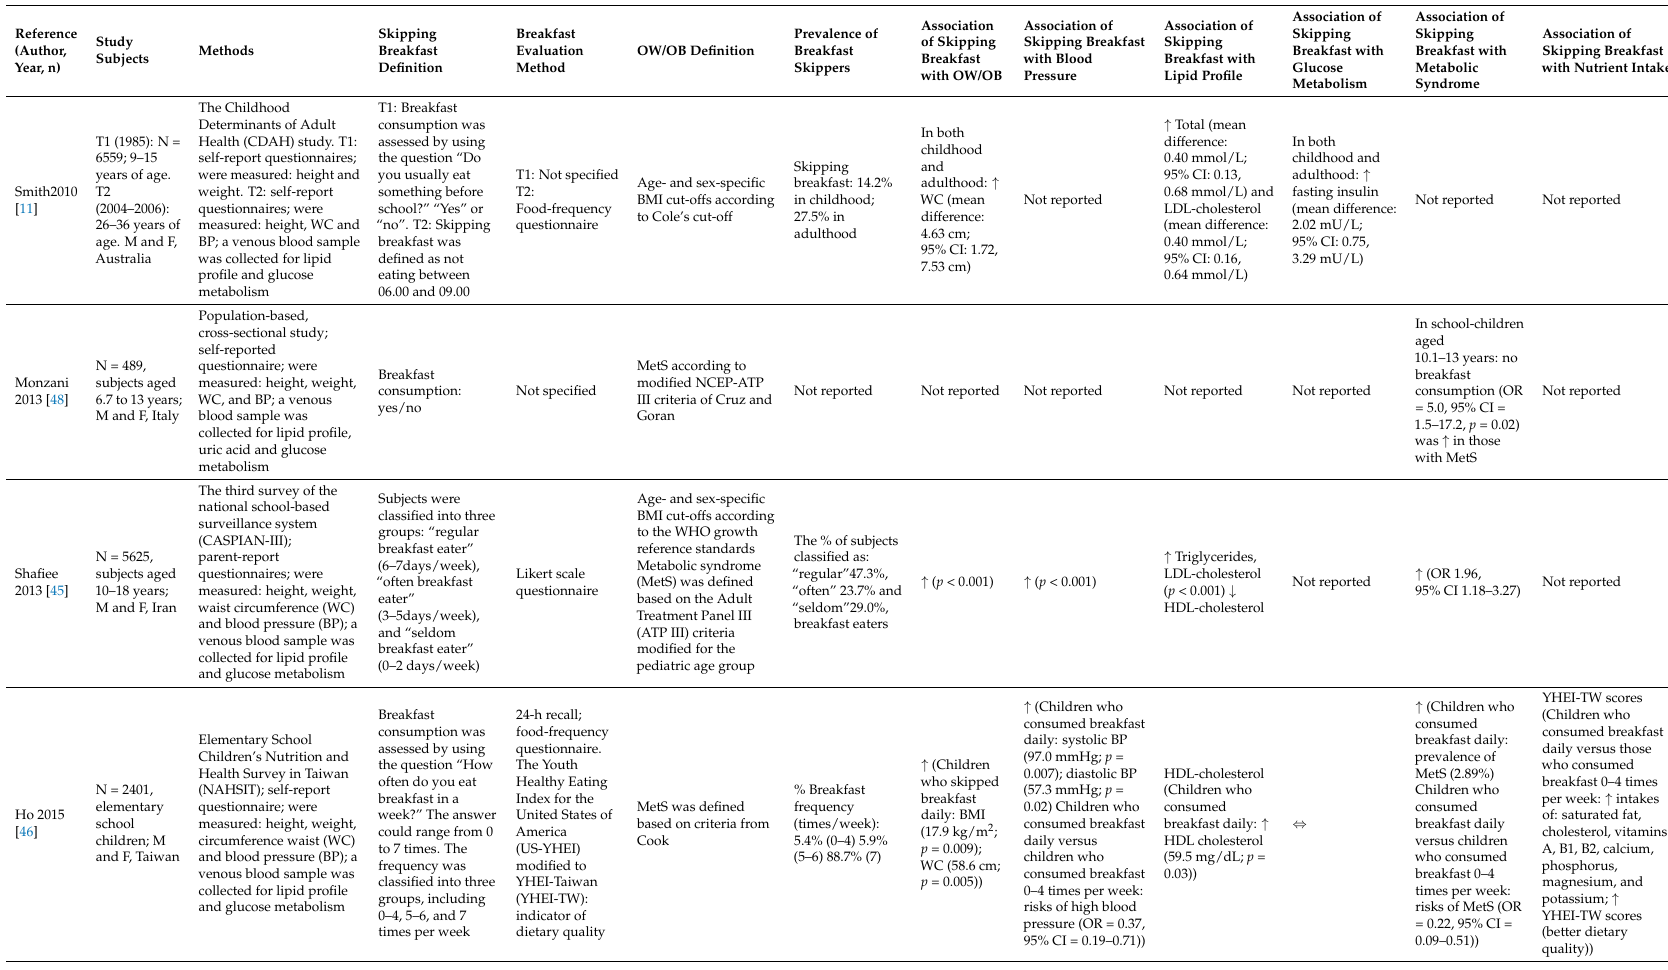
Table 2. Summarized studies’ characteristics on metabolic variables and skipping